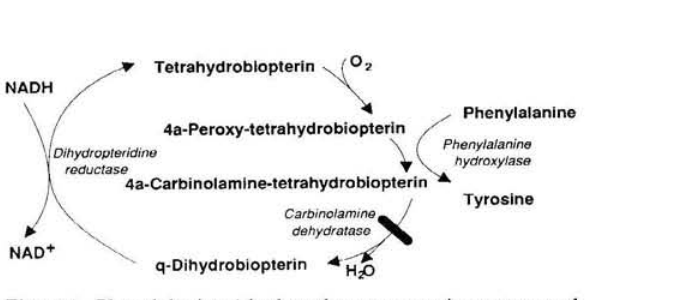
Figure 1. Phenylalanine-4-hydroxylase regenerating system and possible defect in primapterinuria.